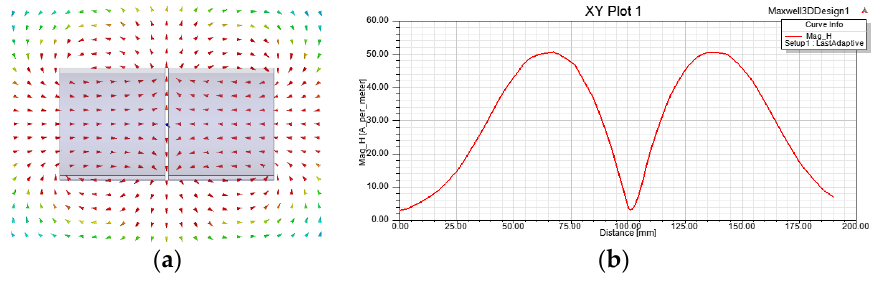
Figure 9. MAXWELL simulation of low-frequency coil ( a ) and axial magnetic field intensity distribution ( b ).